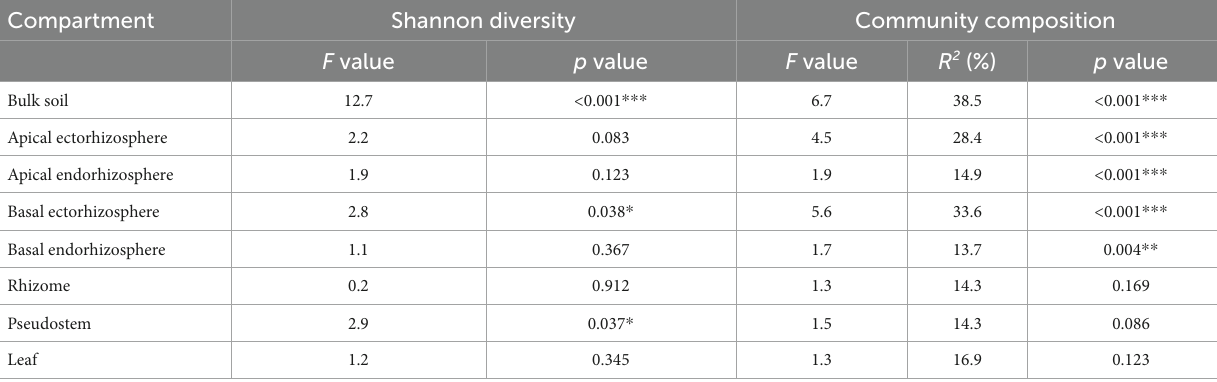
TABLE 2 The influence of soil on the alpha diversity (Shannon’s Diversity Index) and composition (Hellinger transformed OTUs) of fungal communities within each compartment, as assessed by ANOVA and PERMANOVA,